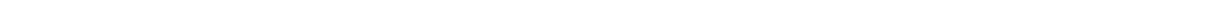
Fig. 4 EphB1 induces a neuroprotective transcriptional programme in astrocytes which is distinct to IL-6 treatment. a , b Predictive EphB1/IL-6 signalling to the STAT3 transcriptomic network. Connections are based on the provided evidence by Ingenuity Pathway Analysis. Red lines indicate connections of STAT3 to in fl ammatory transcripts, which are overlapping between EphB1-induced and IL-6-induced networks. Both larger node size and darker orange colour indicate increased transcript induction while smaller node size and darker blue colour codes decreased gene expression. c Diagram indicates selection criteria for qPCR based validations. d Graph shows mean fold changes of transcripts in astrocytes (ACs) following EphB1 or IL-6 treatments normalised to untreated controls ( n = 3 cultures from 6 mice; ** p = 0.003, F = 58.44 for Cebpd and ** p = 0.009, F = 44.1 for Trim30a between EphB1 and IL-6 treated groups; one-way ANOVA with Bonferroni post hoc test). e Fluorescence images demonstrate Cebpd IR in EphB1-induced or IL-6-induced ALDH1L1-positive astrocytes. f Dot plot graph shows relative integrated density measurements of nuclear Cebpd IR to the mean of control values after normalisation to background densities ( n = 55 for EpHB1, n = 67 for IL-6 from three astrocyte cultures of six mice; ** p = 0.002, unpaired t -test). Percentages represent the proportion of astrocytes with higher values than the control threshold. g Immuno fl uorescence images of motor neurons (MNs) displaying cleaved-caspase3 IR in glutamate toxicity assays, in which the effect of AC conditioned media (ACM) was examined. ACM derived from astrocytes receiving various treatments: untreated or treated astrocytes by EphB1 with or without pre-incubation by ephrin-B1 siRNA and also by IL-6. h Graph demonstrates the mean proportion of glutamate (100 μ M) toxicity induced cleaved-caspase3 positive spinal cord motor neurons and the in fl uences imposed on this by various ACM ( n = 6, 5, 4, 4, 5 motor neuron populations from six mice in two independent experiments; **** p ≤ 0.0001, ns p = 0.668, *** p = 0.0007 in comparison with non-glutamate treated negative controls or ** p = 0.019, ns p = 0.832 and ns p = 0.997, F = 16.41 in comparison with glutamate and ACM treated control, one-way ANOVA with Tukey ’ s post-test). Scale bar: 20 μ